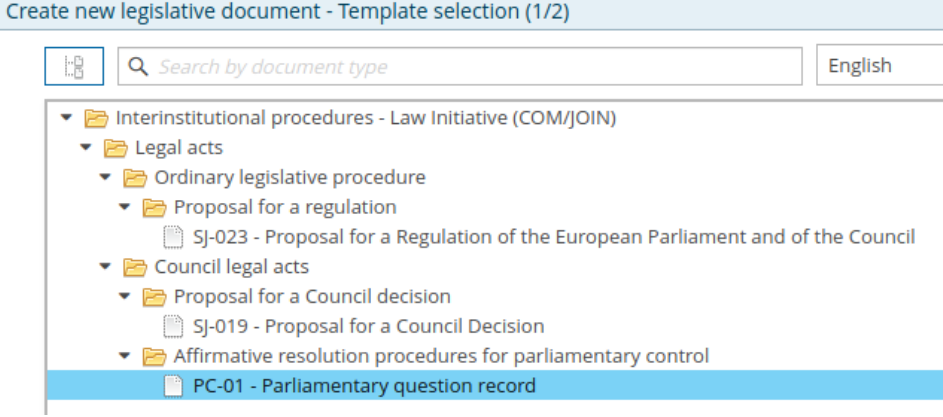
Figure 2. Document wizard for a parliamentary control entry.